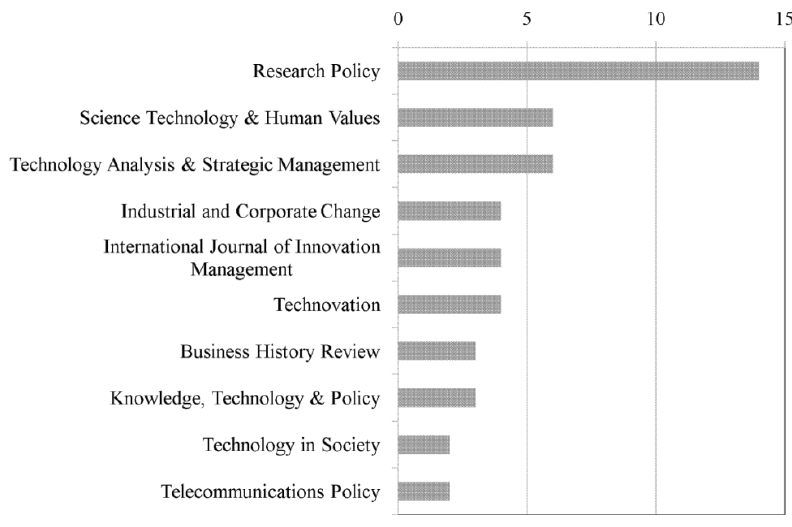
Figure 2. “Most frequently citing